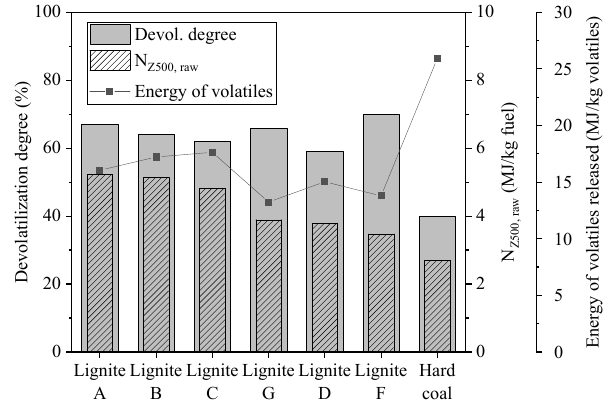
Figure 6. The devolatilization degree and ignition potential of lignites and the hard coal.